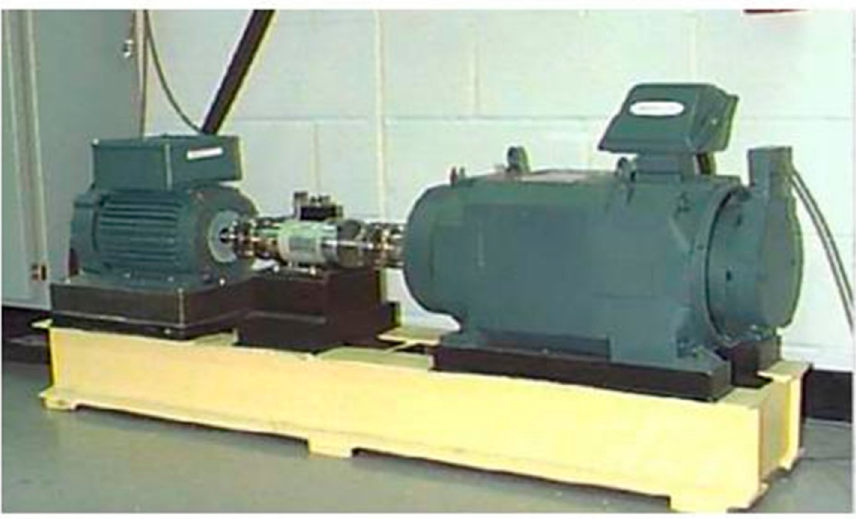
Figure 7. The test platform of CRWU.